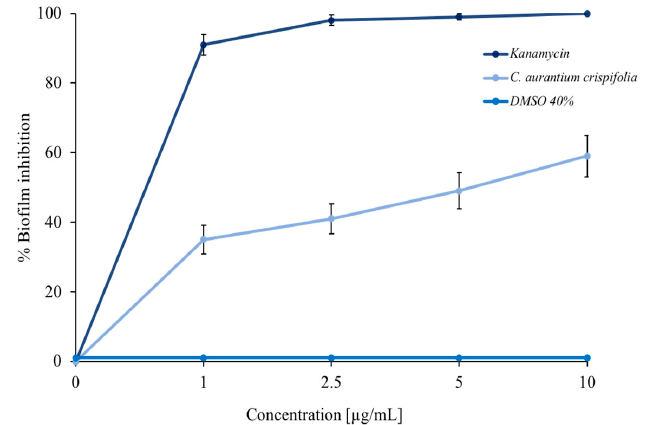
Figure 4. Percentage of M. smegmatis biofilm inhibition. Different concentrations of C. aurantium ‘Crispifolia’ EO were tested ( x -axis). The assays were performed in three independent experiments. Standard deviations are always less than